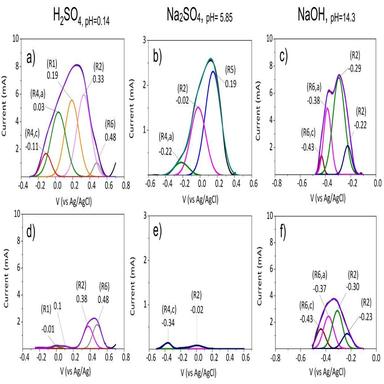
SWV curve deconvolution for a–c) CeCNT_10E and d–f) CeCNT_10P materials in a, d) 1 M H2SO4, b, e) 1 M Na2SO4 and c, f) 1 M NaOH.